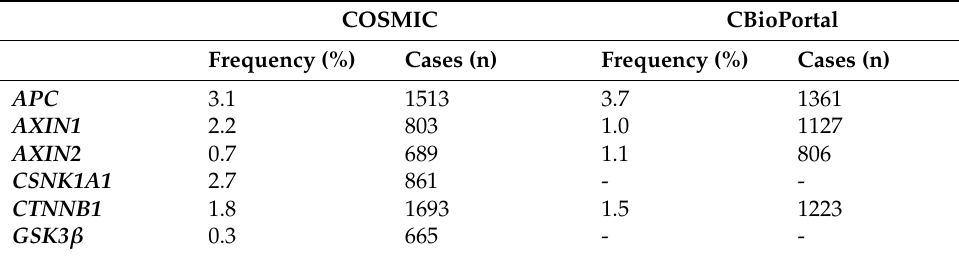
Table 1. Mutations in genes encoding components of the Wnt/ β -catenin pathway in CCA. COSMIC CBioPortal Frequency (%) Cases (n) Frequency (%) Cases (n)